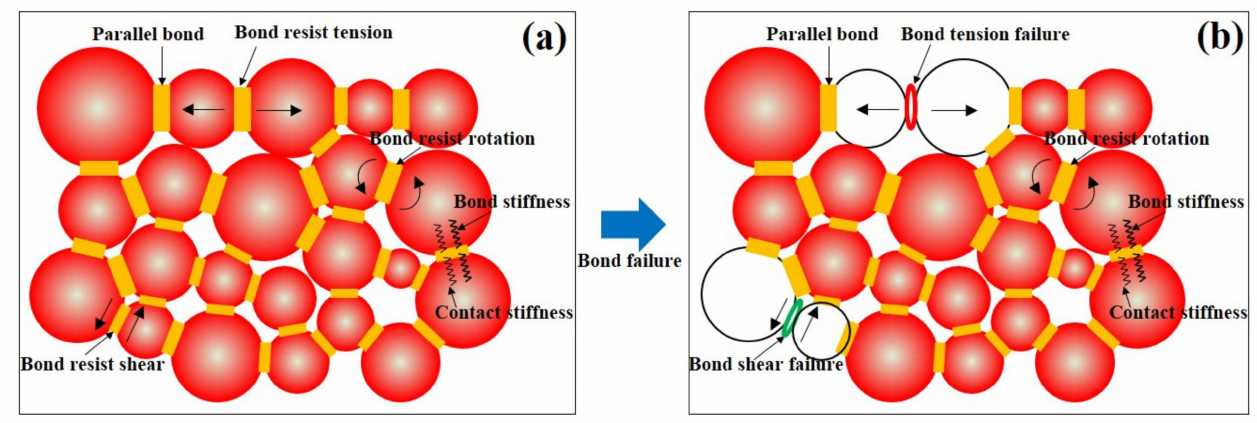
circle (Figure 14b).